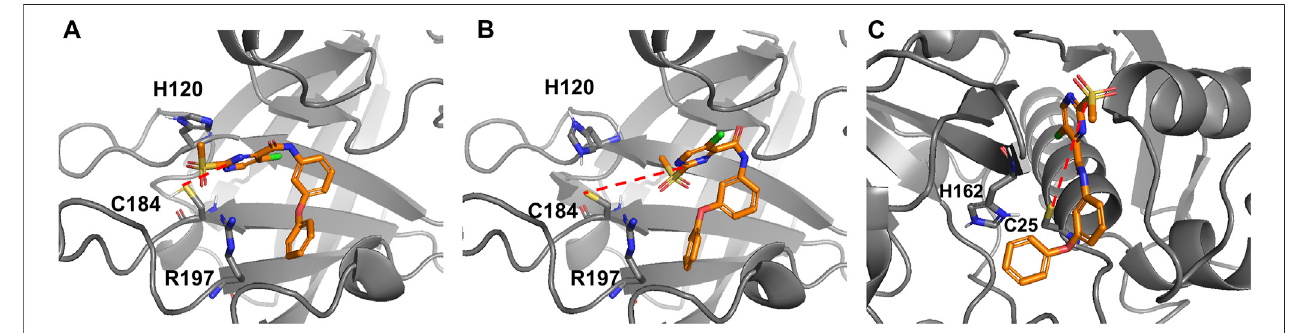
FIGURE10| Dockingposesofcompound 5a reversiblyboundtoSrtAandrhodesain. (A) DockingtoaSrtAreceptorwithreverselyprotonatedCys/Hisdyad(pdb: 2kid). Distance (Cys 184 -SH/C-2) (cid:1) 4.6 Å. (B) Docking to a SrtA receptor with an arti fi cial zwitterionic Cys (cid:1) /His + dyad (pdb: 2kid). Distance (Cys 184 -S - /C-2) (cid:1) 7.8 Å. (C) Docking to a rhodesain receptor (pdb: 2p7u). Distance (Cys 25 -S - /C-2) (cid:1) 7.8